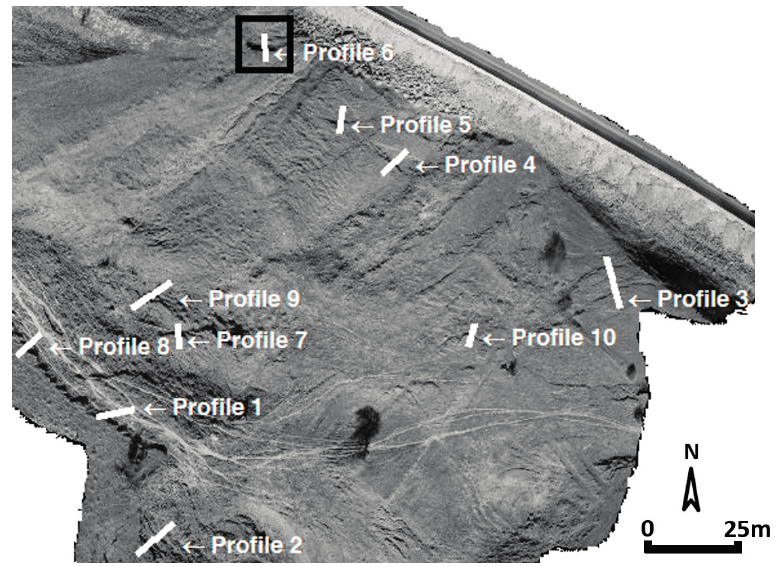
Figure 8. Showing some profiles that intersected the fractures around the landslide